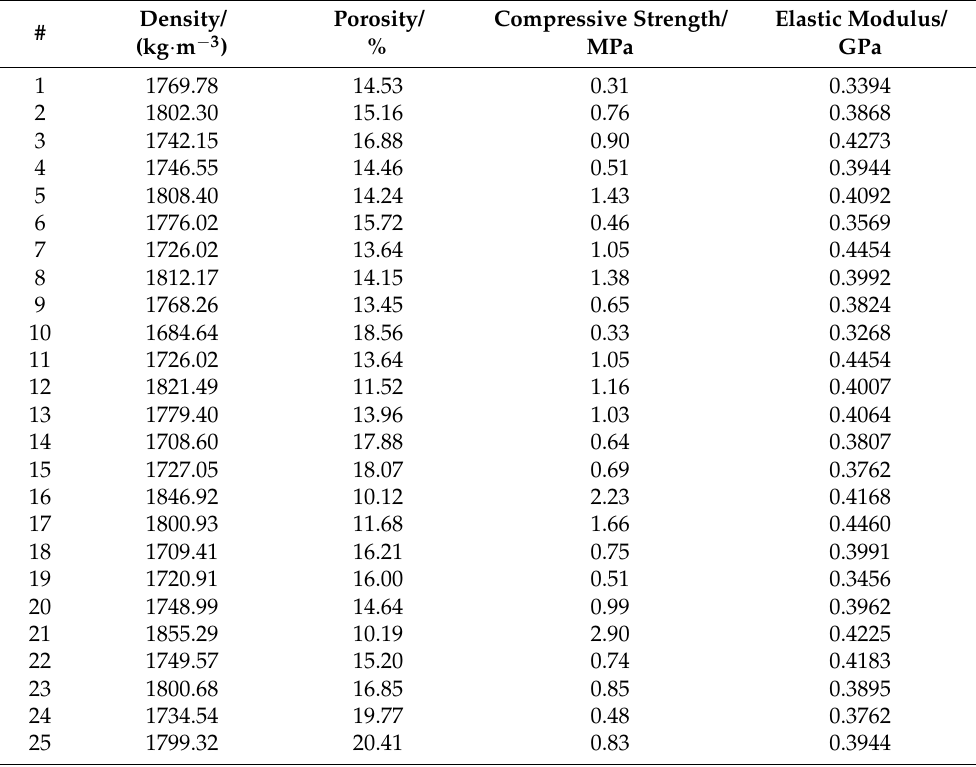
Table 4. Experimental results of material